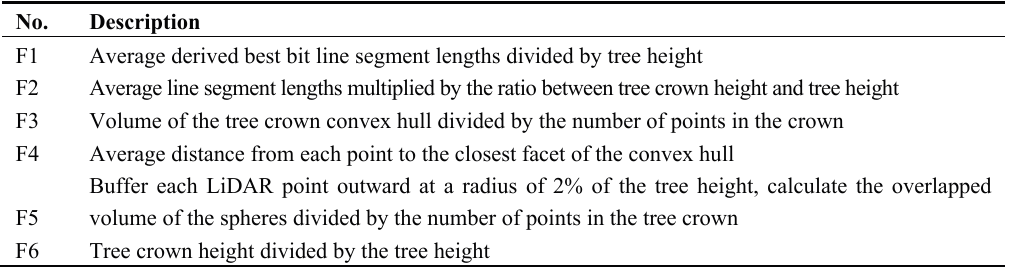
Table 1. List of selected geometric features.